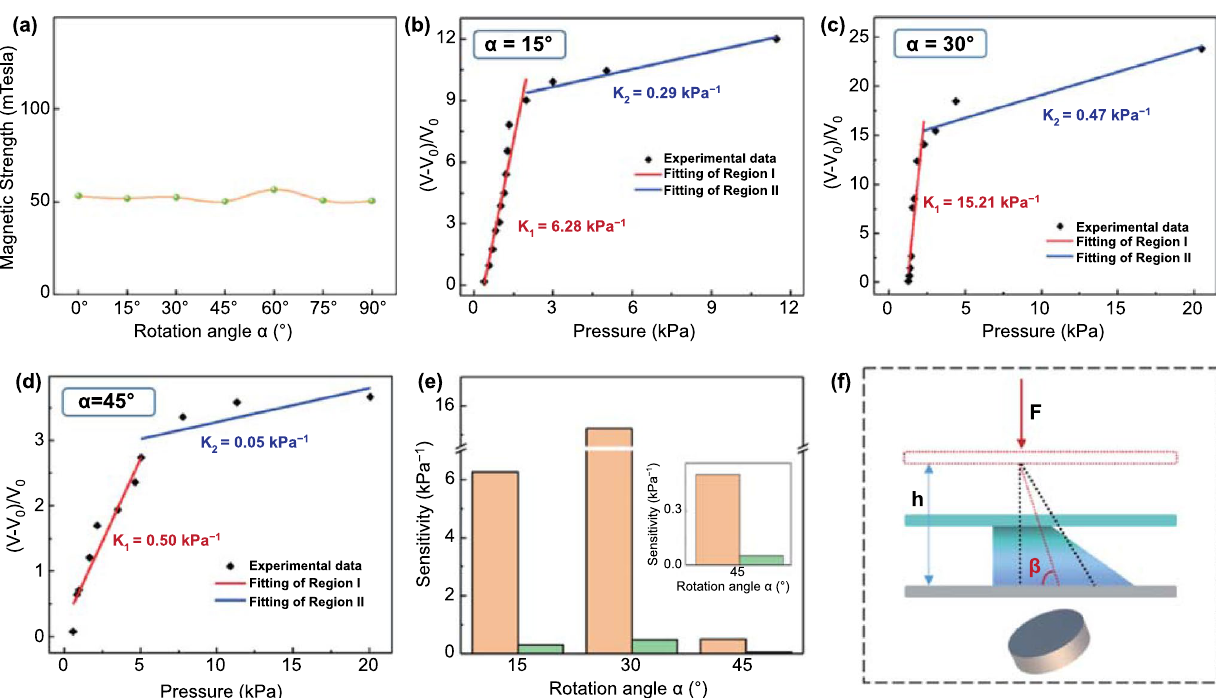
Fig. 4 Pressure sensing performance under different angles (α) with magnet. a Characterization of the magnetic field strength generated under different angles. b‑d The summarized relationship and linear fitting between the relative variations of voltage and the pressure applied on the device under different angles with magnet, from 15° to 45°at 15° intervals. e The summarized variation of sensitivity of pressure sensor under different distances with magnet. f Force analysis diagram when tilted ferrofluid spike is